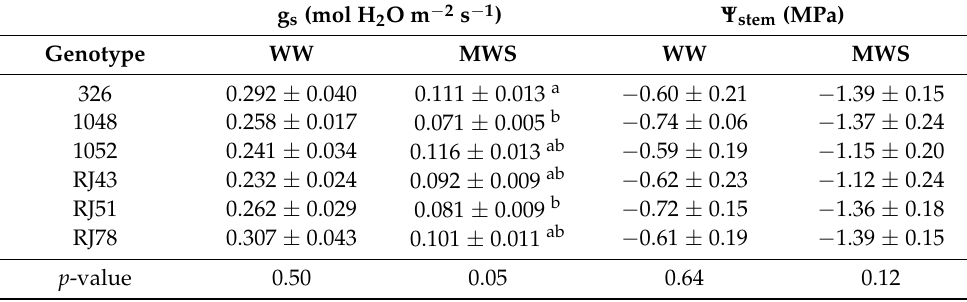
Table 1. Stomatal conductance (g s ) and midday stem water potential ( Ψ stem ) at two irrigation treatments. Lower case letters indicate differences between means (Tukeys tests, p < 0.05).